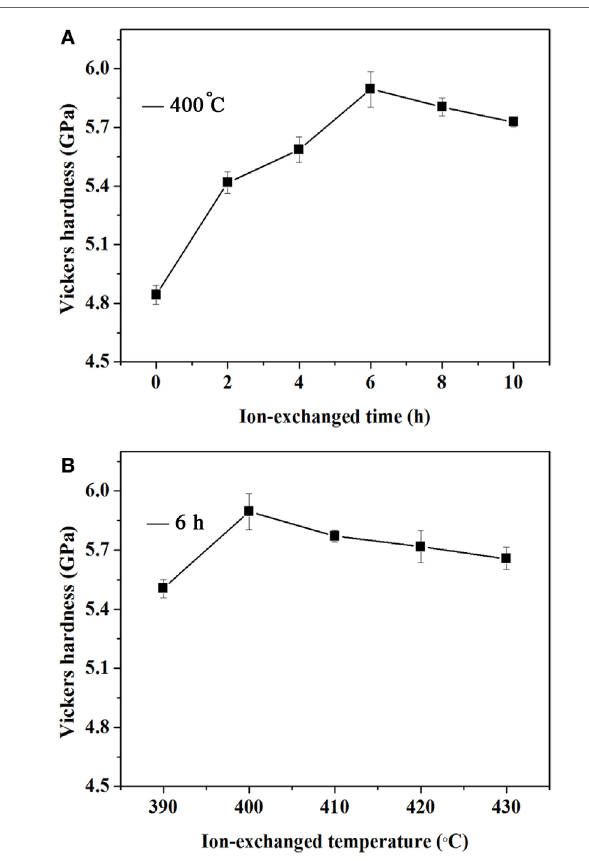
FigUre 3 | Vickers hardness values of x P 2 O 5 –(100 − x )(0.25na 2 O– 0.08al 2 O 3 –0.67siO 2 ) ( x = 5) . (a) Vickers hardness values of the glass treated at 400°C for different ion-exchange durations; (B) Vickers hardness values of the glass treated at different ion-exchange temperatures for 6